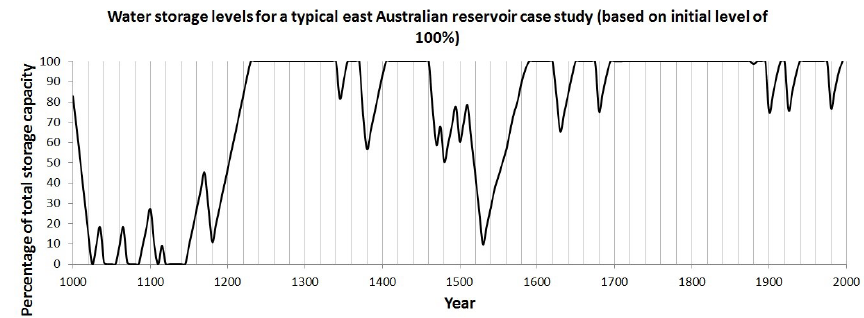
Figure 8. Case study reservoir water storage levels based on initial storage in 1000 CE equal to 100% of